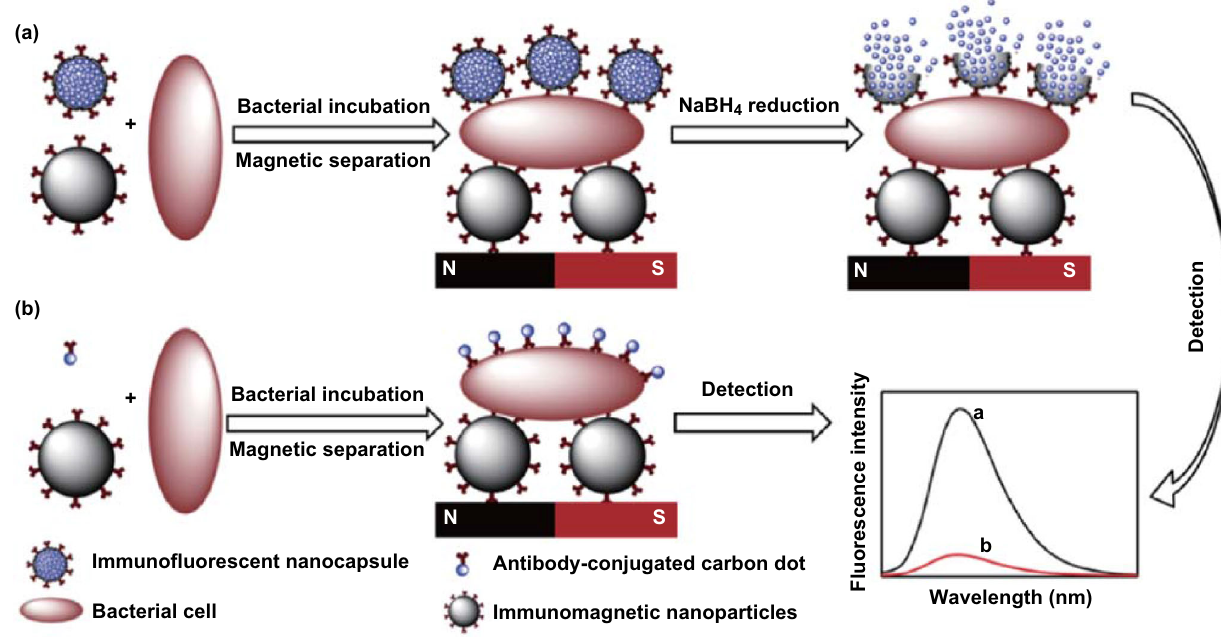
Fig. 19 Schematic illustration of the detection of pathogenic bacteria with a CD-based nanoprobes and b conventional methods [230]. Copyright (cid:2) 2018 American Chemical